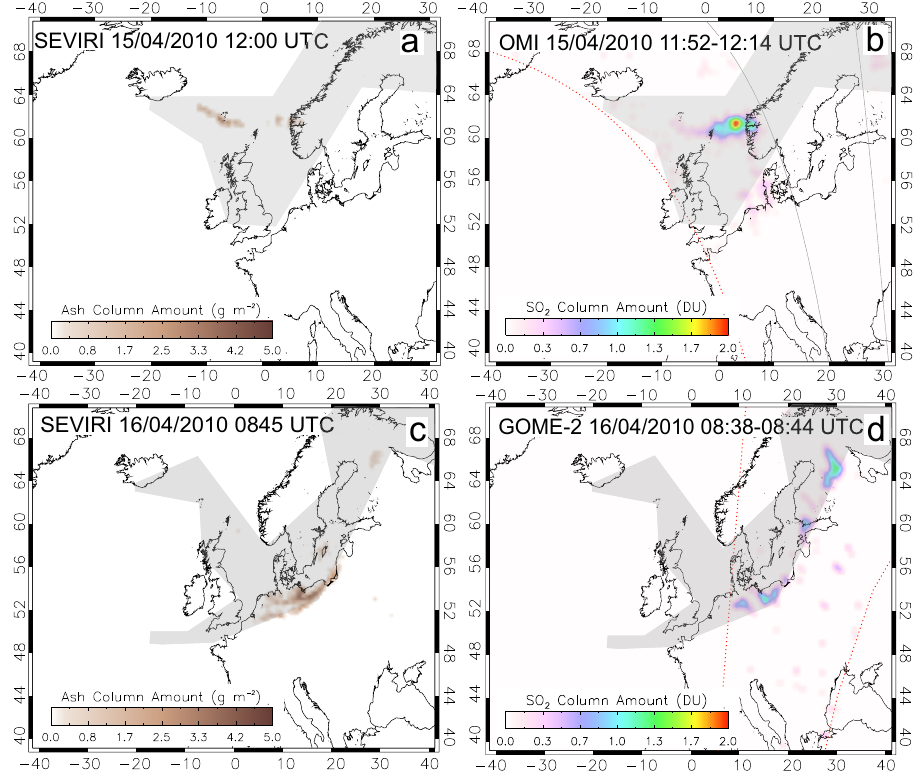
Fig. 2. Near-coincident retrieval of ash from SEVIRI with OMI SO 2 on April 15 ( a and b ) and with GOME-2 SO 2 data on 16 April ( c and d ). Red dashed lines indicate the swath edge of the polar orbiting instruments and grey lines indicate the limit of the OMI row anomaly, between which no useable data are recorded. The grey shaded region indicates the area predicted to contain ash as forecast by the London VAAC at the time of the